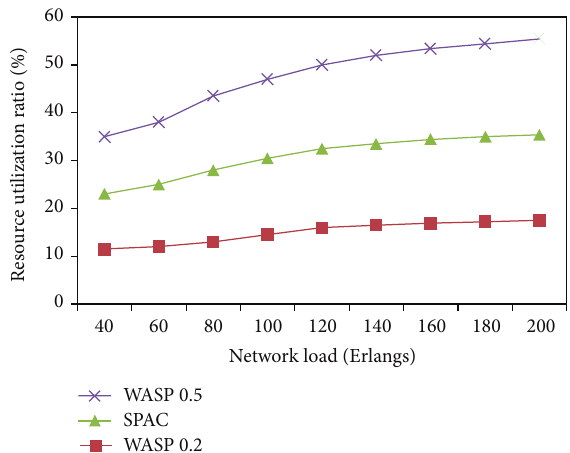
Figure 2: Resource utilization ratio versus network load.